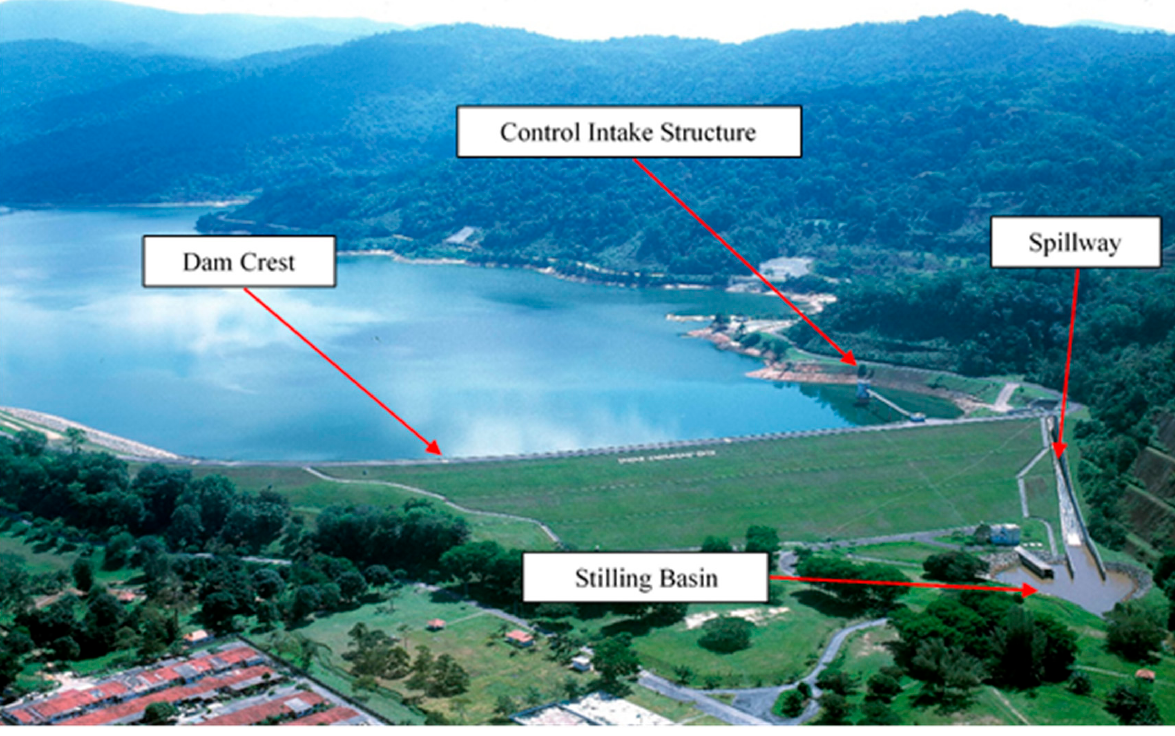
Figure 2. Components of Batu Dam.